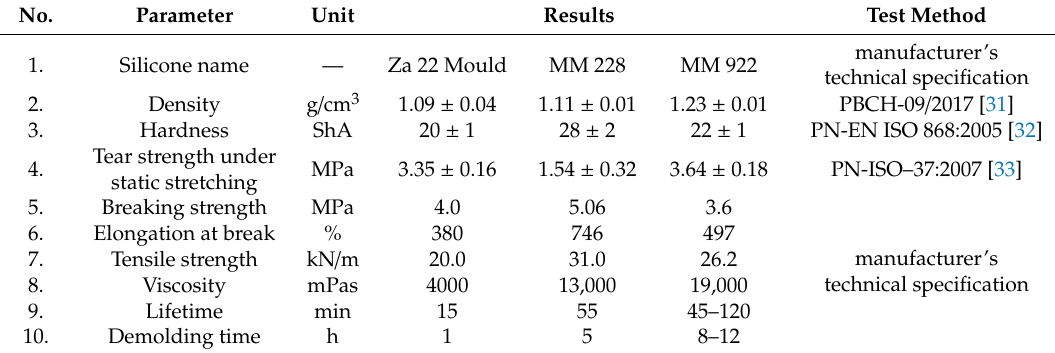
Table 1. Technical specification of silicone elastomers applied for the hybrid silicone-ceramic composites.